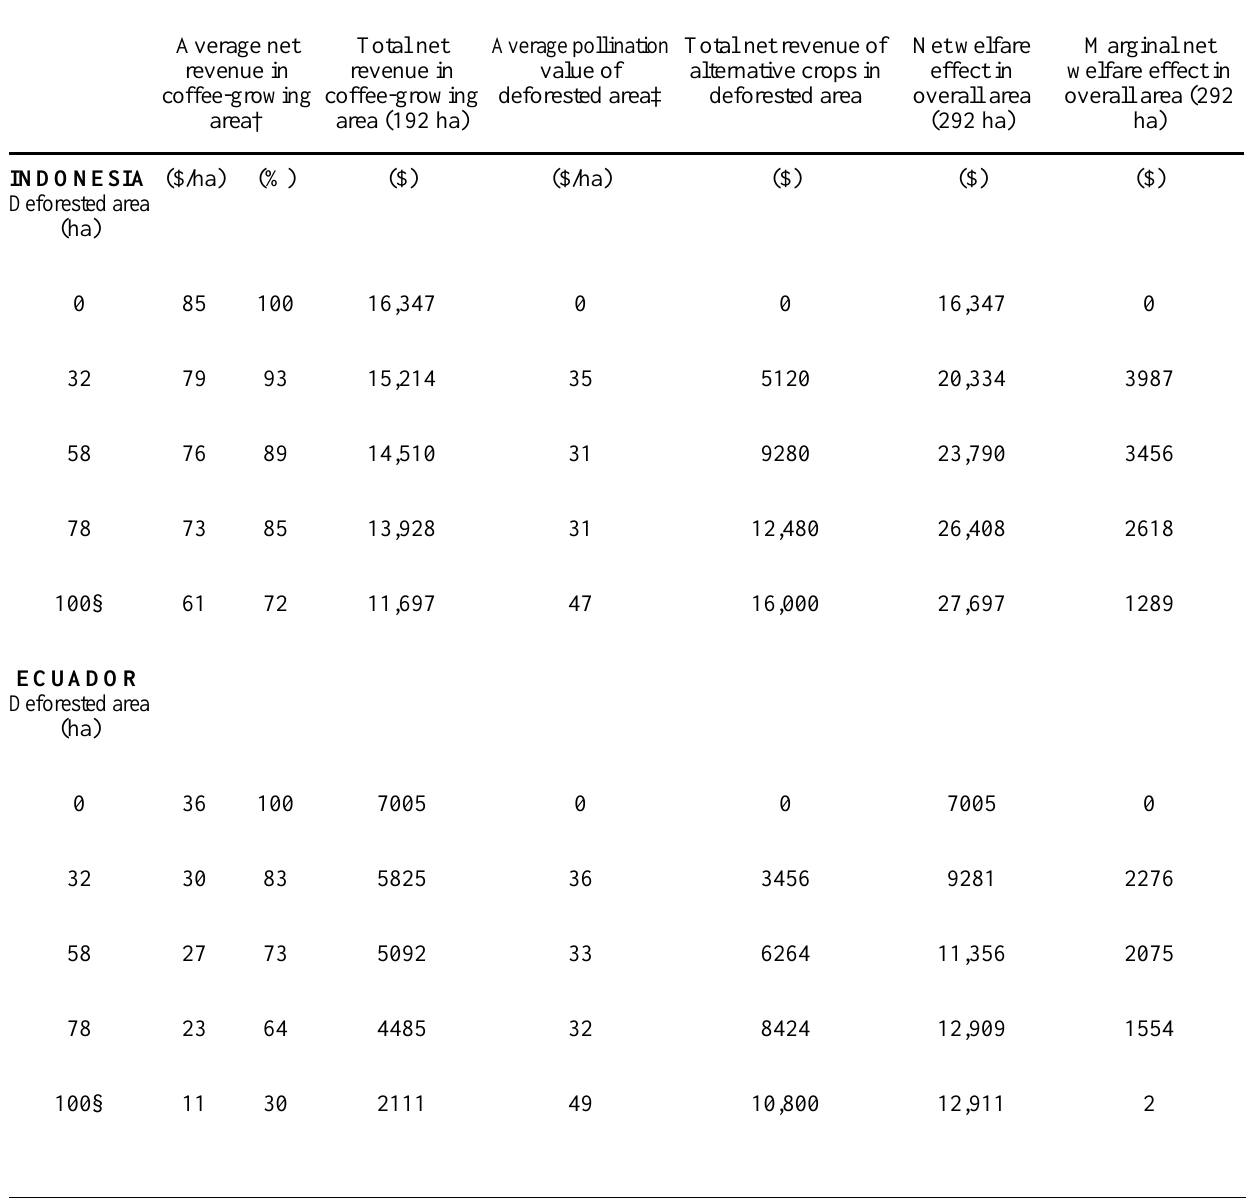
Table 3. Economic impact of deforestation on coffee sites and overall welfare. Scenarios are as in Fig. 3; all monetary values are in